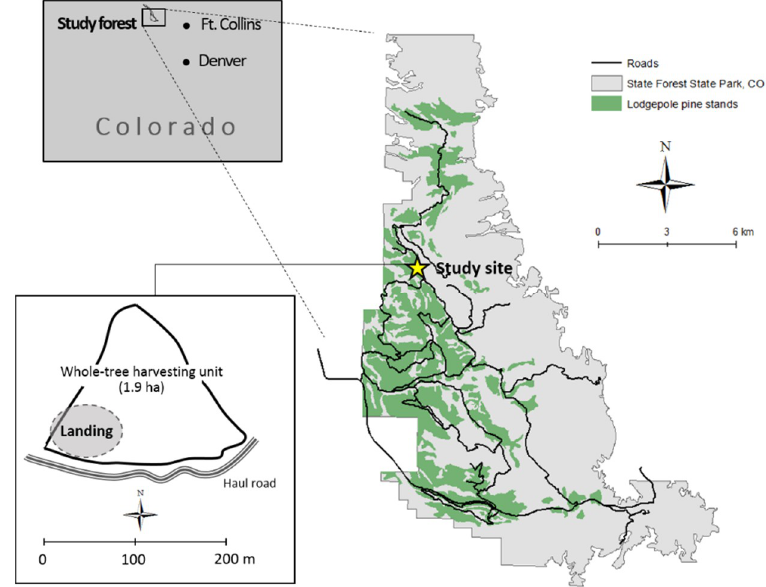
Figure 1. Site map showing the harvesting unit in Colorado State Forest State Park.